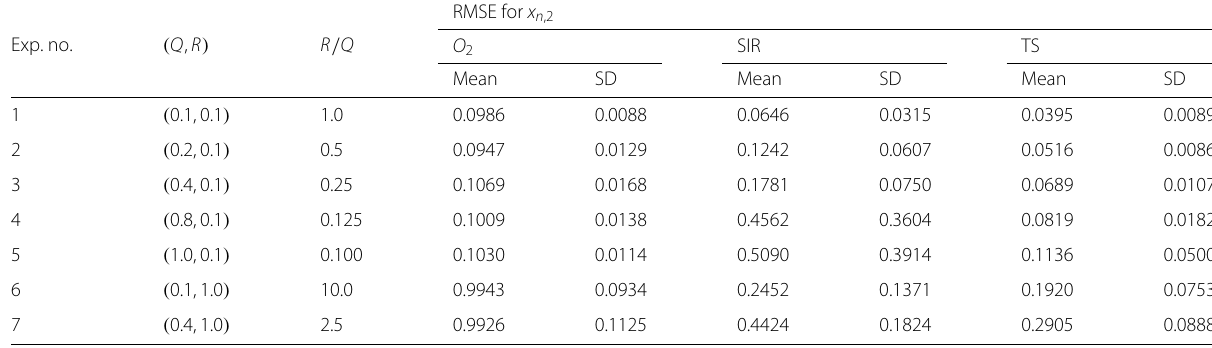
Table 5 Simulation results for Example 1: Mean and standard deviations of the RMSE for three different estimators of x n ,2 , namely, O 2 , the posterior mean based on SIR and the posterior mean based on TS Exp.